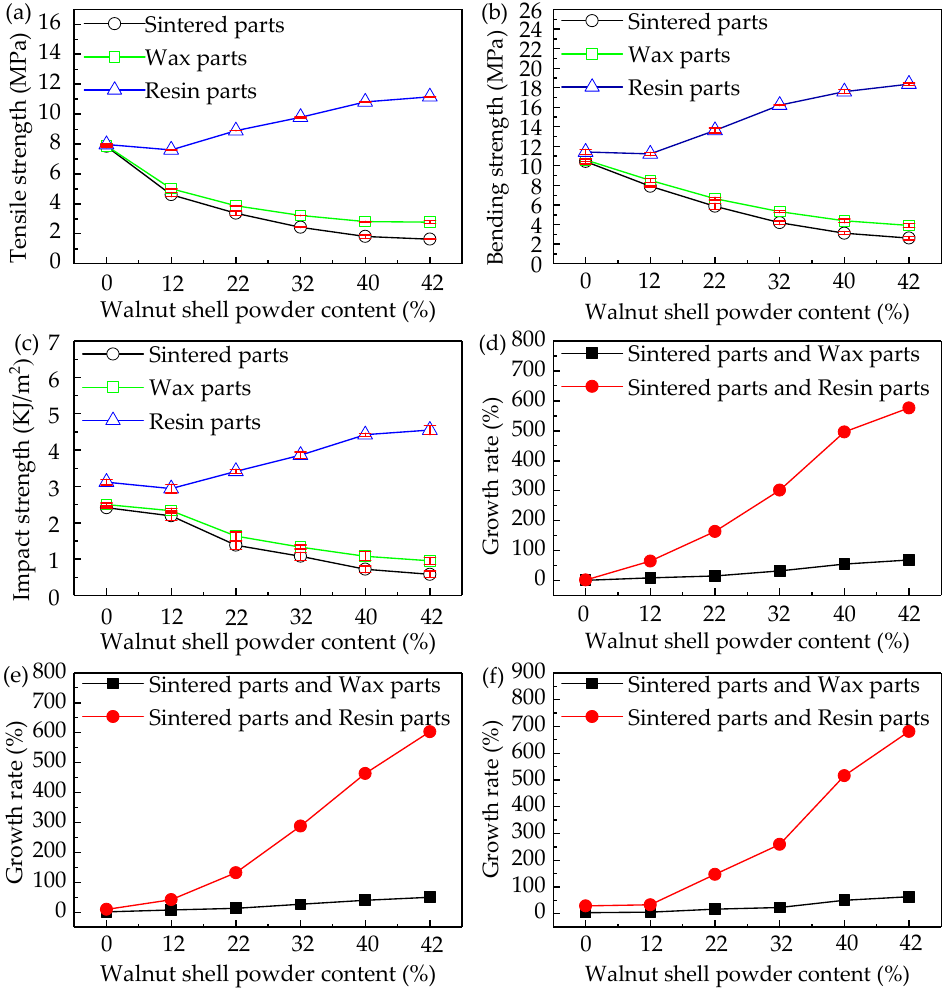
Figure 9. The mechanical properties change and growth rate curves of sintered parts and after-treatment parts with different ingredient proportions: ( a ) tensile strength; ( b ) bending strength; ( c ) impact strength; ( d ) tensile strength growth rate; ( e ) bending strength growth rate; and ( f ) impact strength growth rate.